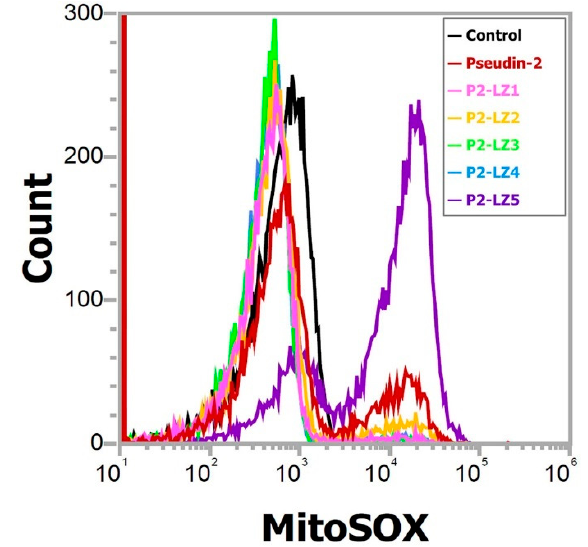
Figure 9. ROS generation induced by peptides in C. tropicalis mitochondria.